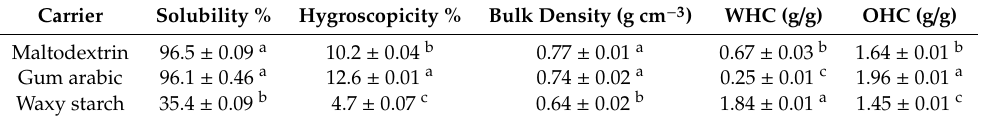
Table 4. Technofunctional properties of freeze-dried